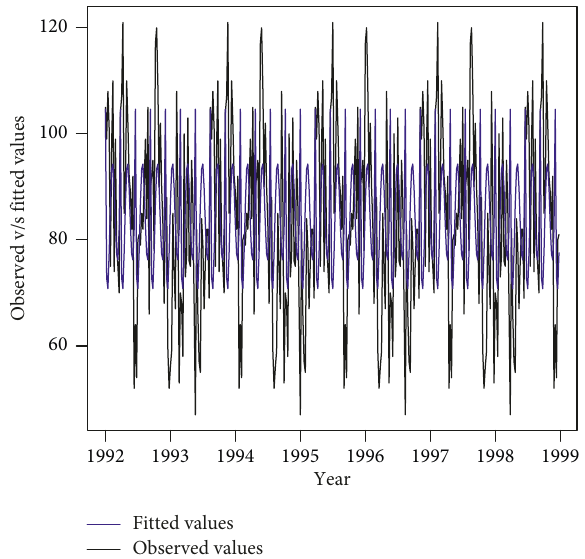
Figure 16: Observed hospitalization rate and fitted model.